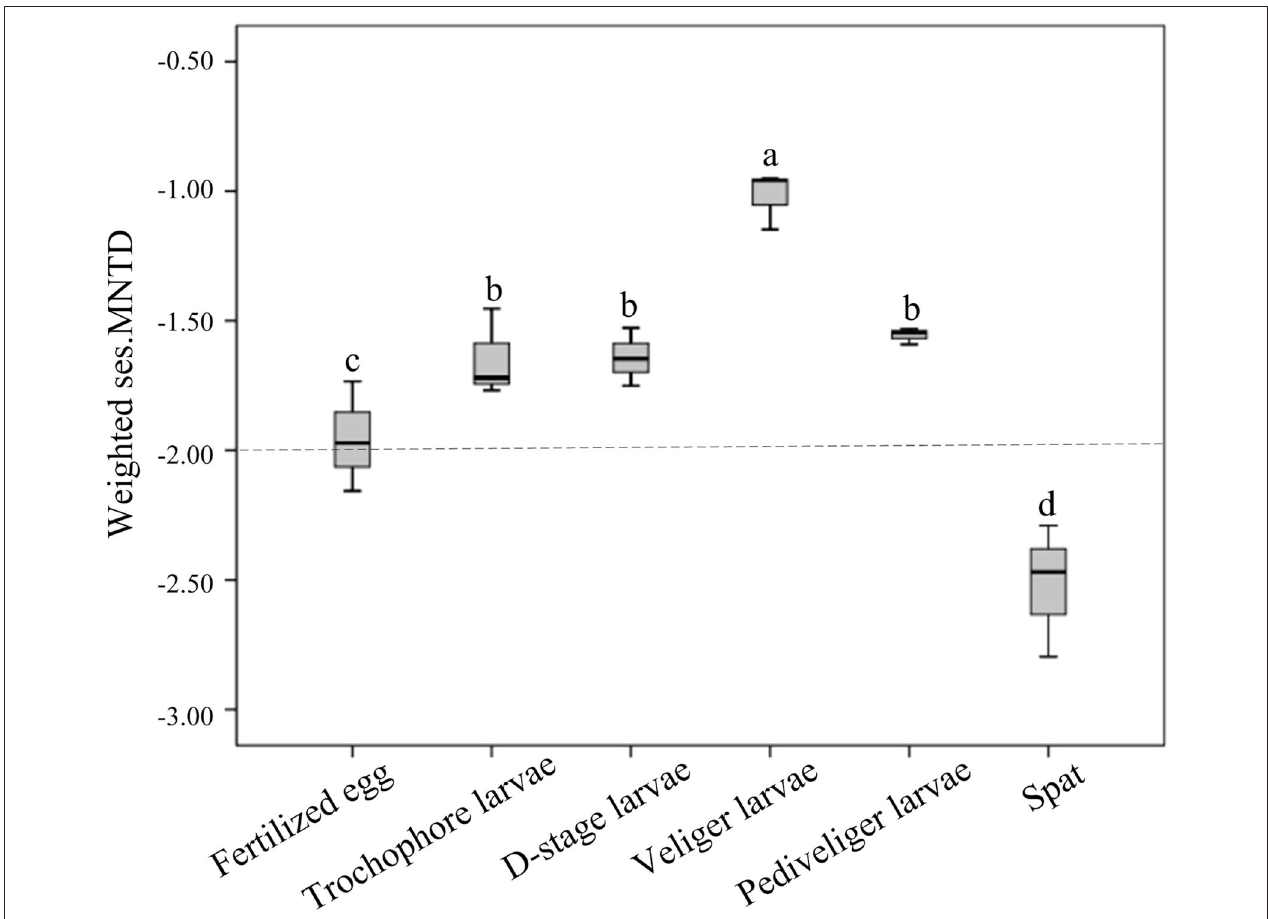
FIGURE 4 | The boxplots show the ecological processes (as measured by the weighted standardized effect size of the mean nearest taxon distance, weighted ses.MNTD) of larval bacterial communities. The dotted line indicates equal roles for both. A community below the line denotes that determinism dominantly governed the bacterial community assembly, while a community above the line denotes that stochasticity was predominant. The different lowercase letters show significant differences among distinct developmental stages based on a one-way